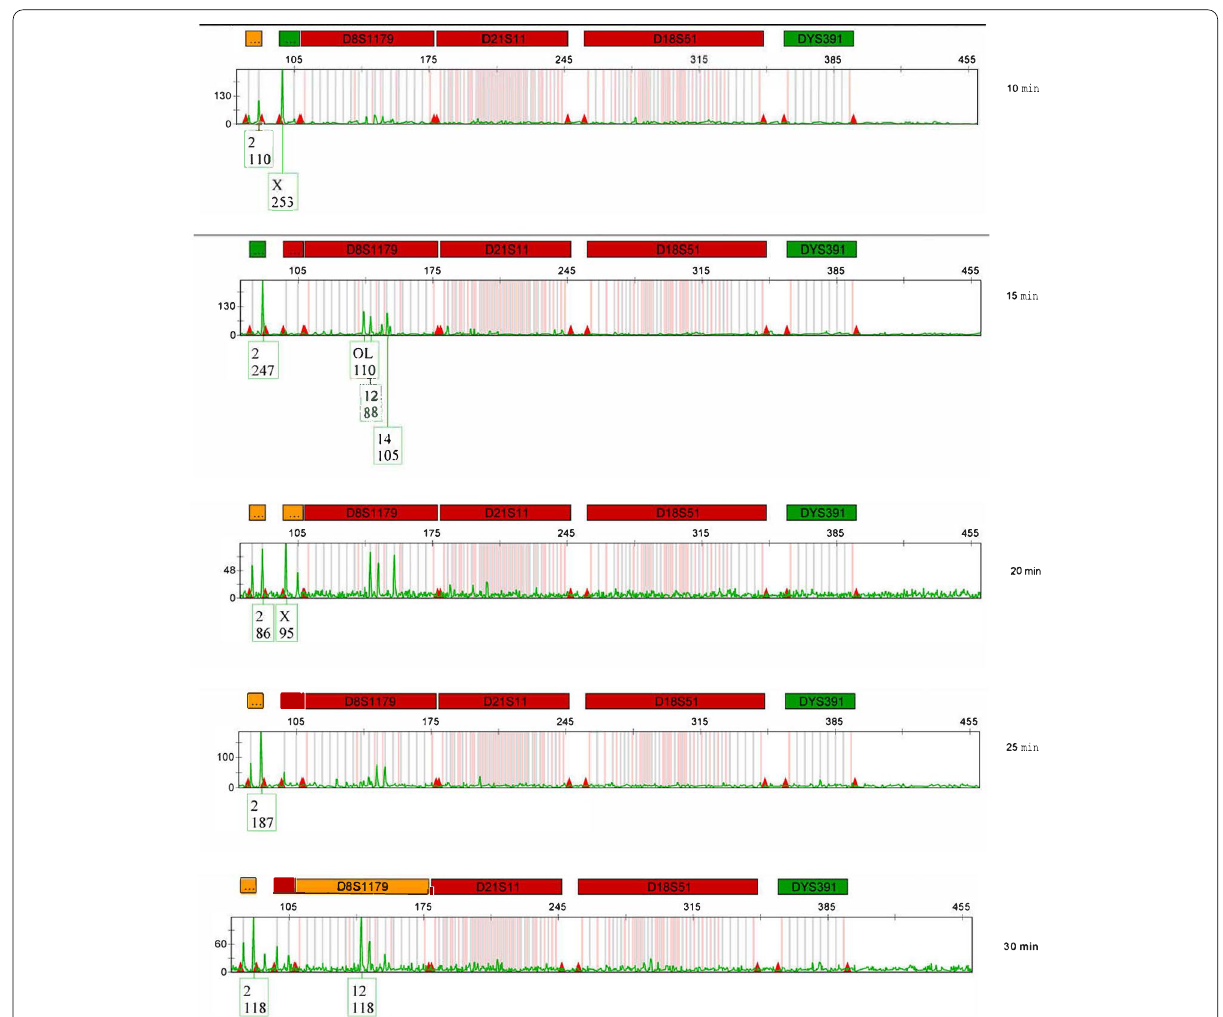
Fig. 5 The effect of 10% bleach in performing DNA